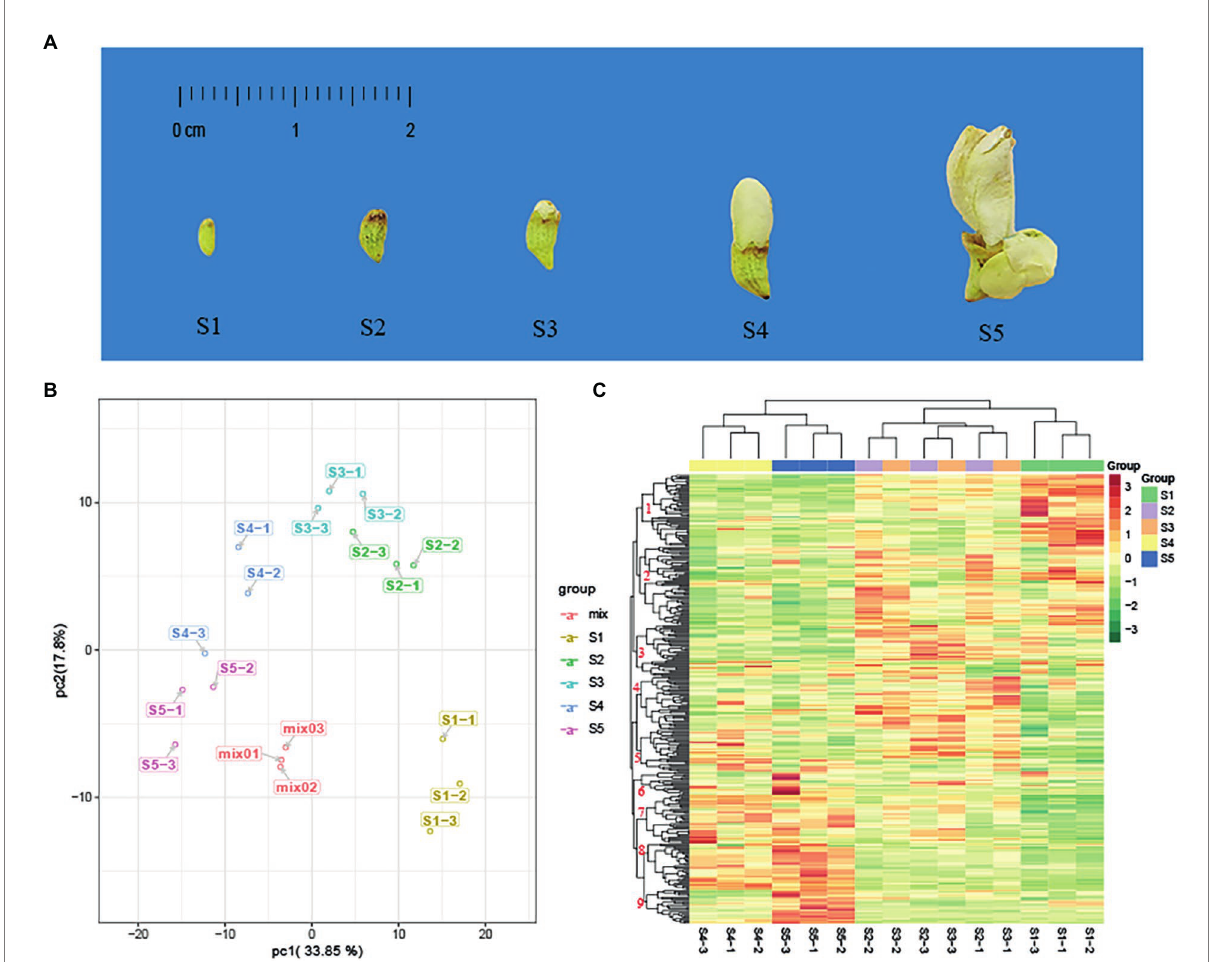
FIGURE 1 Principal component analysis (PCA) and heat map analysis of metabolites in five developmental stages of the flower of Sophora japonica . (A) Phenotypic features of S. japonica in the five developmental stages of the flower (S1–S5). (B) PCA score plot. (C) Clustered heat map of all metabolites. A column represents a sample, and a row represents each metabolite. The abundance of each metabolite is represented by a bar with a specific color; red indicates high abundance, whereas metabolites with a low relative abundance are shown in green (color key scale is right of the heat